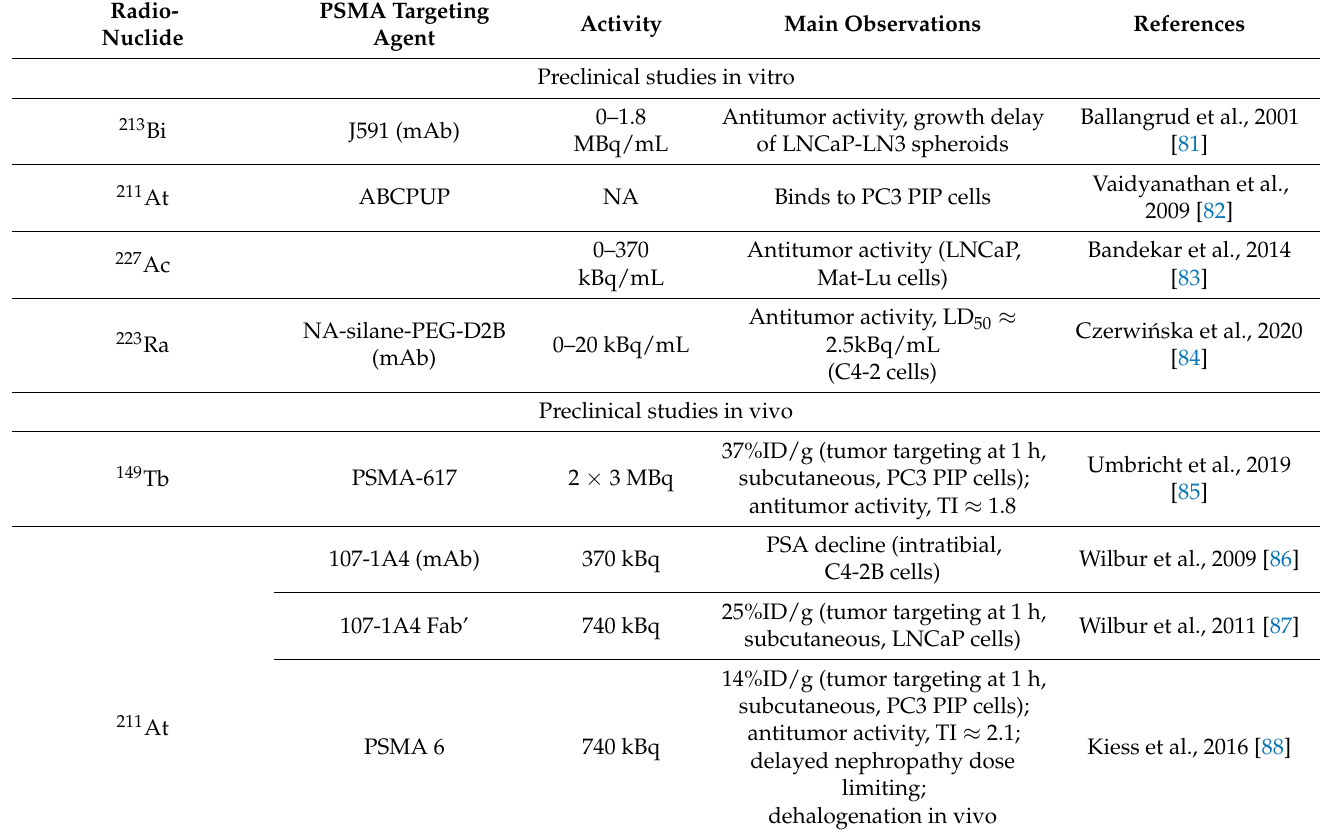
Table 4. Overview of α -emitting radionuclides and PSMA-targeting agents investigated in preclinical studies for targeted prostate cancer therapy. mAb, monoclonal antibody; NA, not available; Fab’, antigen-binding fragment; %ID/g, percent injected dose per gram of tissue. Therapeutic index (TI) is defined as the median survival of the treatment group divided by the median survival of the untreated